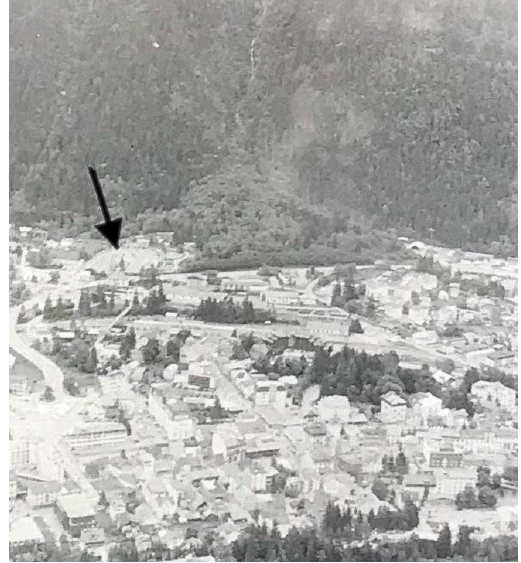
Figure 3. Arrow to cemetery on alluvial fan in Chamonix.